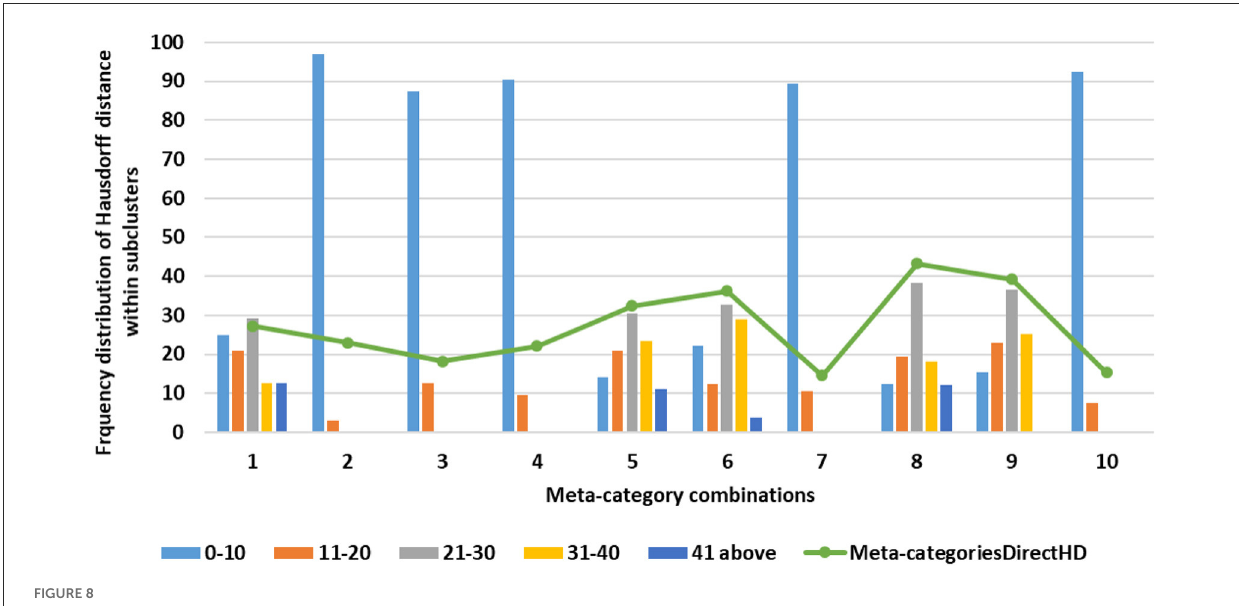
FIGURE8 Super-category combination threshold